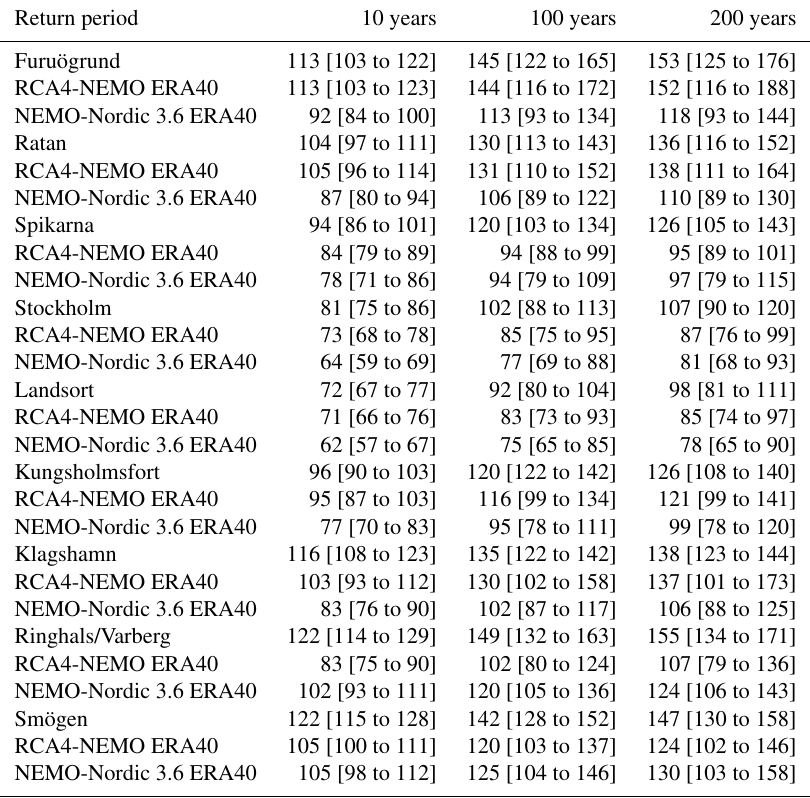
Table 4. Extreme sea levels (cm) using a GEV distribution with the blockmaxima method. The first line is reproduced from Södling and Nerheim (2017, Table 5.3); the second line is from RCA4-NEMO ERA40 (1961 to 2005); the third line is from NEMO-Nordic 3.6 ERA40 (1961 to 2005). The values in brackets indicate the 95% confidence